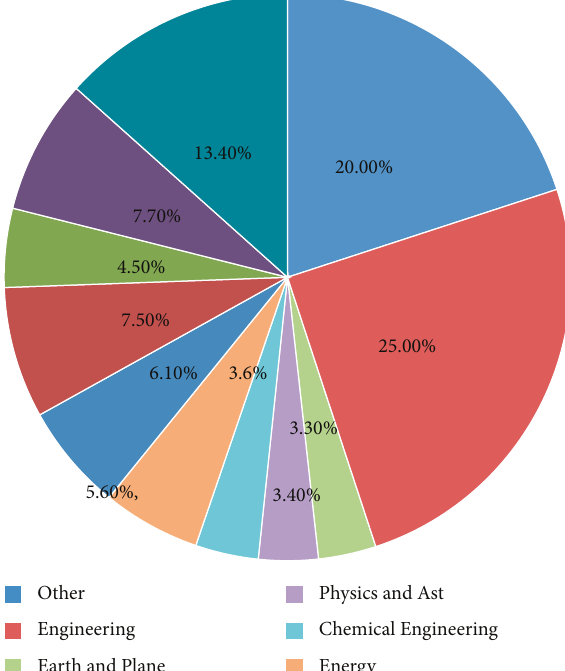
Figure 6: Pie chart depicting article distribution by disciplines for state-of-the-art review articles.